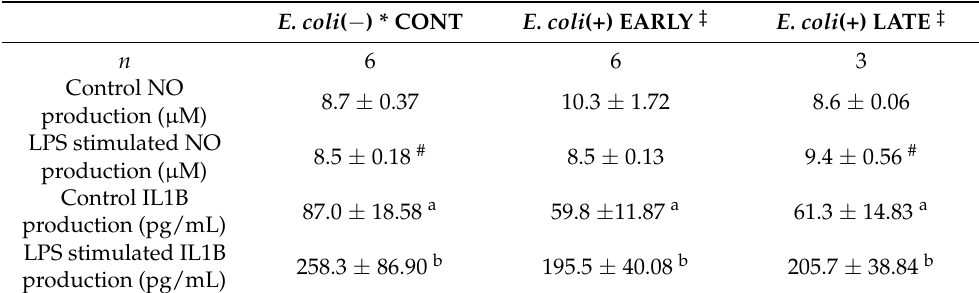
Table 1. Production of NO and IL1B in vitro by PBMCs isolated from E. coli ( − ) and E. coli (+) cows with or without stimulation with 500 ng/mL LPS for 2